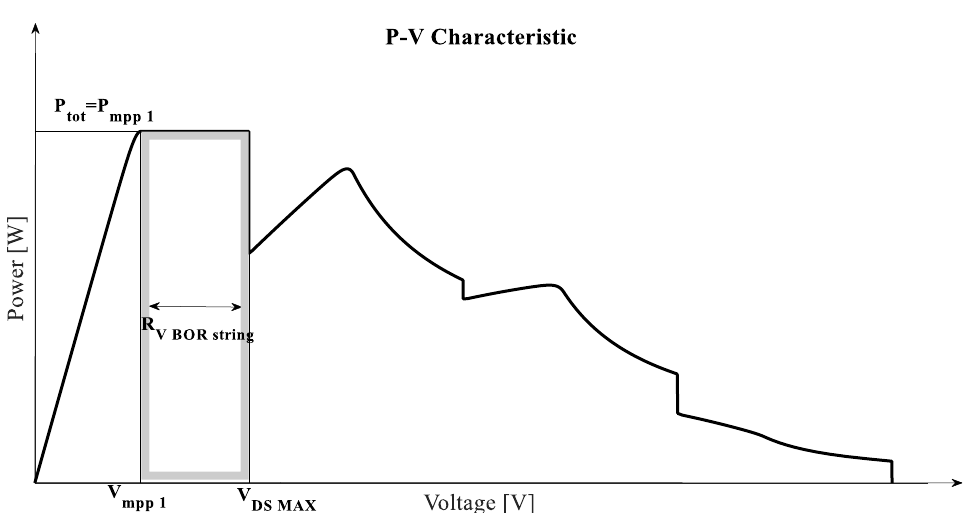
Figure 12. P-V characteristic of the series connection of four Figure 12 . P-V characteristic of the series connection of four SCPVMs.